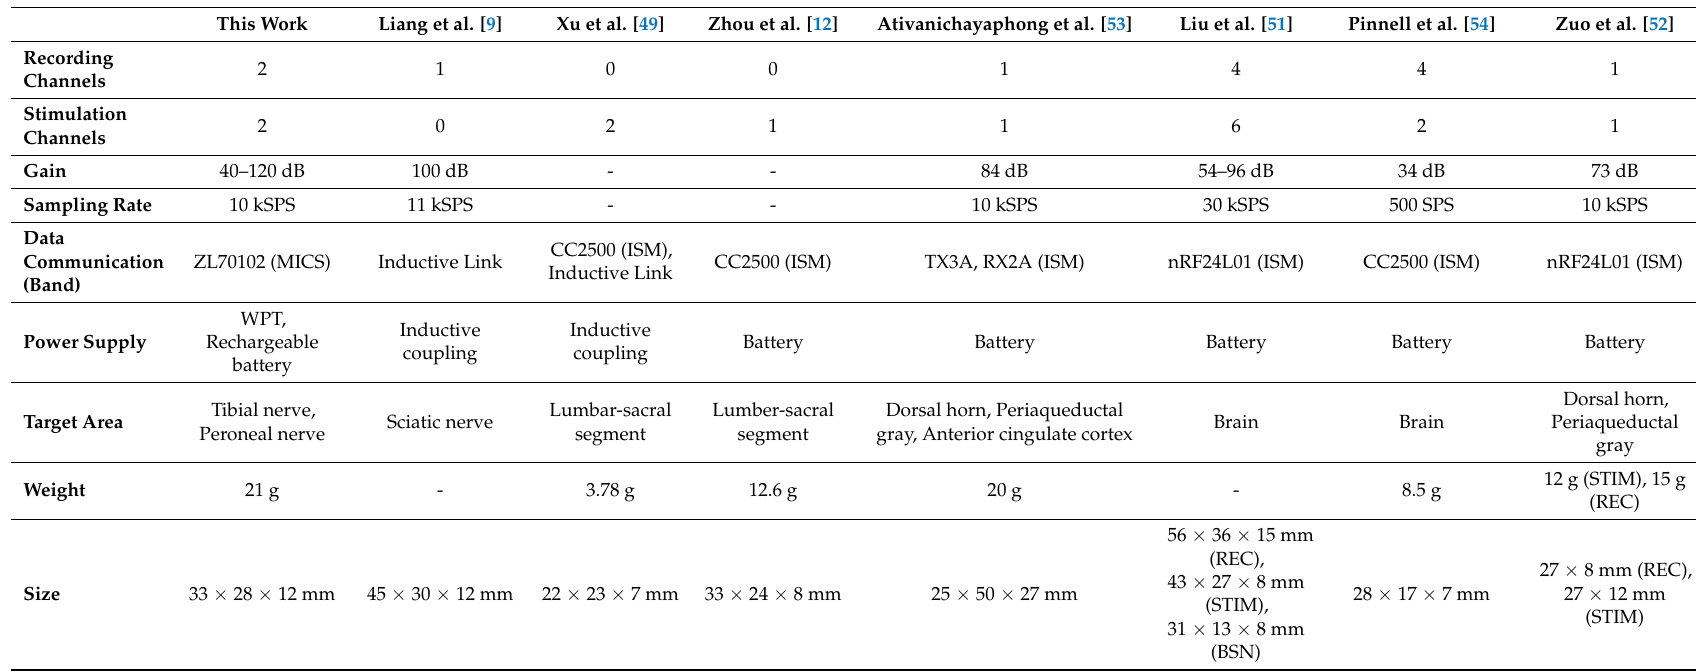
Table 8. Comparison of wireless neural interface